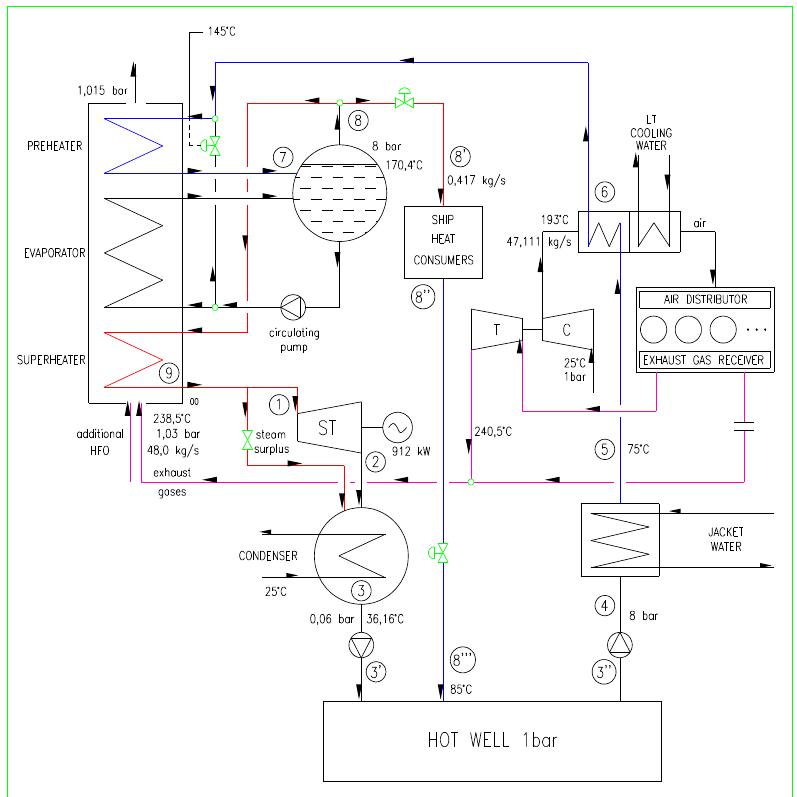
Figure 1. Schematic diagram of the CHP plant with a steam Rankine